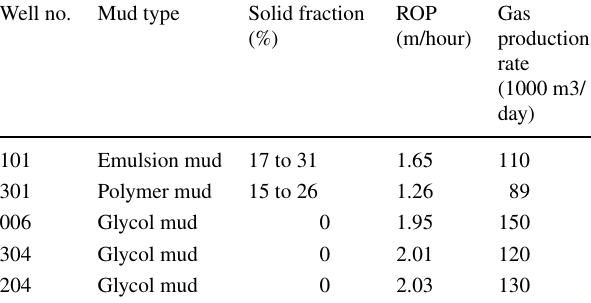
Table 13 Comparison of clay mud and glycol mud Well no.